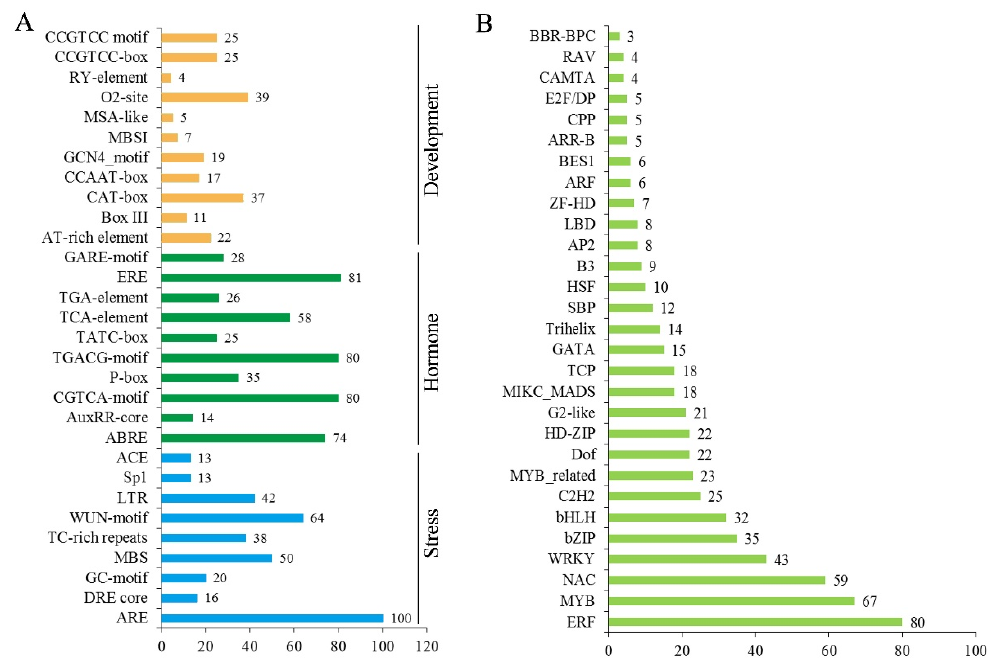
Figure 8. Analysis of cis -acting regulatory elements and TF binding site in the CsNPF promoters. ( A ) Putative cis -acting regulatory elements of CsNPF genes. ( B ) The top 30 riched TF gene families with potential binding sites in the CsNPF promoter regions.